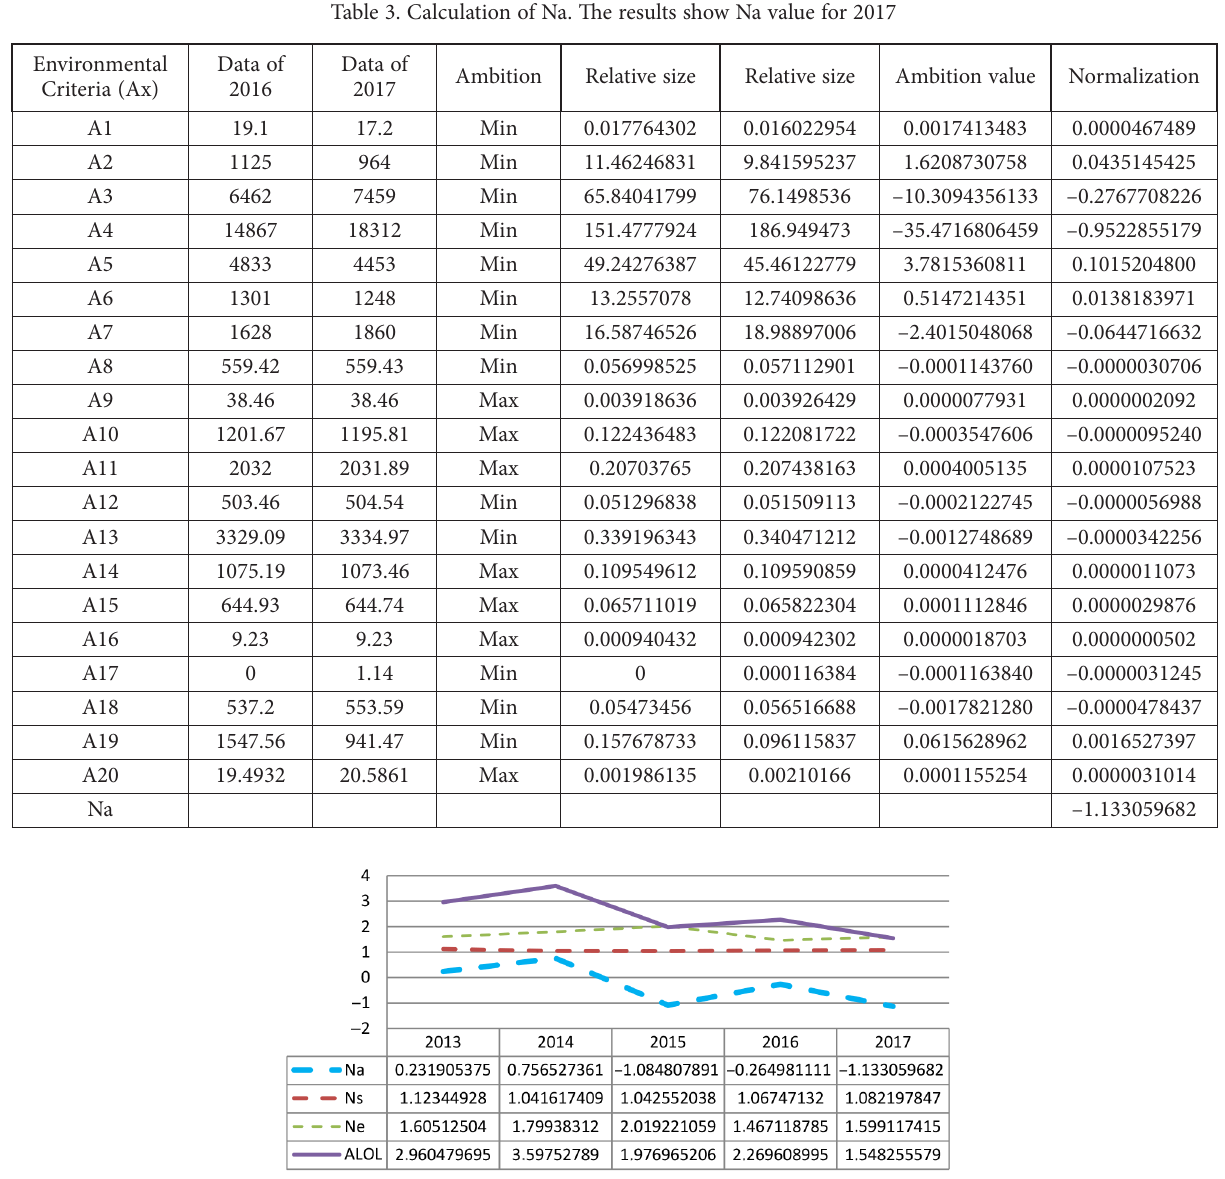
Figure 2. ALOL results in case of Klaipeda city. The data showed deteriorating land